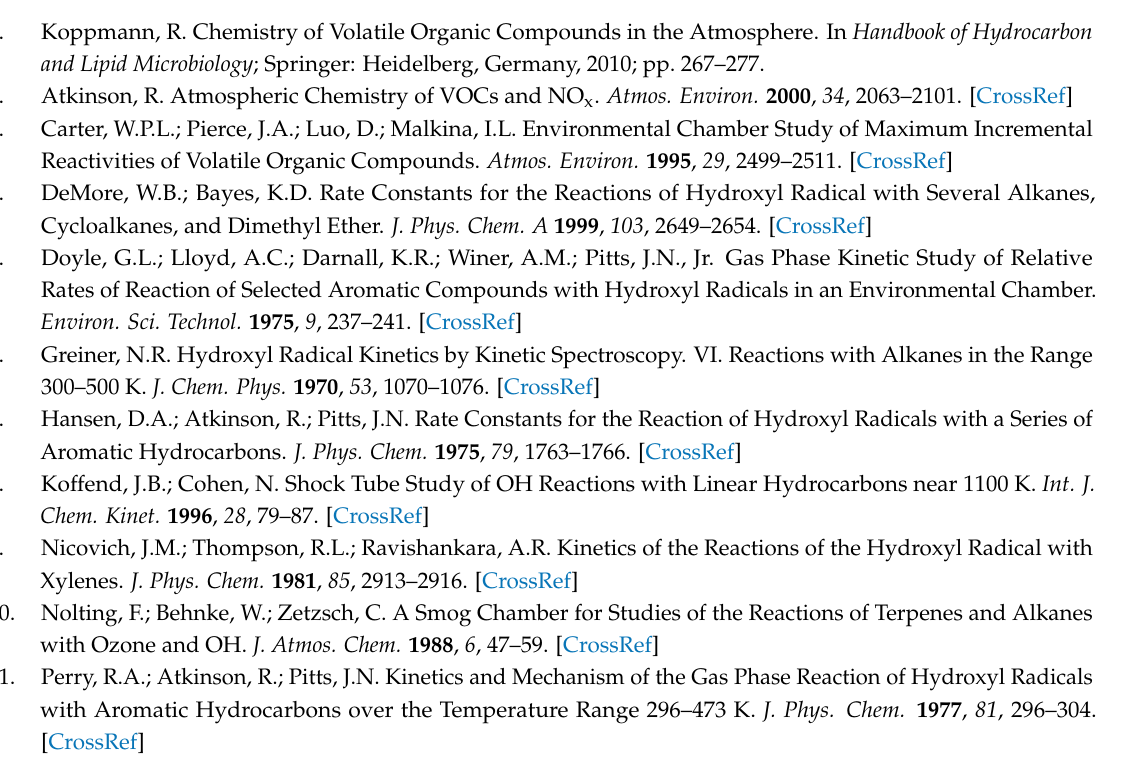
Figure S1: Schematic flowchart of the sample enrichment system connected with gas chromatographic analysis of the gas phase in the smog chamber, Figure S2: Dosage of methyl nitrite into the smog chamber, using a twin of gas containers. This method warrants a fairly constant production of OH, Figure S3: Decrease of the hydrocarbon concentrations (normalized by n -perfluorohexane) by the reaction with OH during a smog chamber run at 248 K, Figure S4: Plots of ln ( c 0 / c t ) of hydrocarbons versus toluene (reference substance) from data points of three experimental runs at 288 K, respectively ( (cid:53) , and (cid:3) distinguish data points from different experimental runs), Figure S5: Plots of ln ( c 0 / c t ) of hydrocarbons versus toluene (reference substance) from data points of two (cid:35) experimental runs at 248 K, respectively ( (cid:53) and distinguish data points from different experimental runs), Figure S6: Arrhenius plots of the rate constant for the reaction of OH radicals with n -heptane, Table S1: Studies (cid:35) below room temperature for the reaction of OH radicals with hydrocarbons, Table S2: Rate constants for the reaction of OH radicals with hydrocarbons at 248 K, Table S3: Arrhenius parameters A and B corresponding to the equation k OH = Ae ( − B / T )